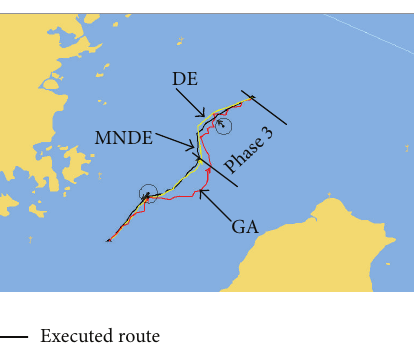
Figure 8: A crossing scenario in open